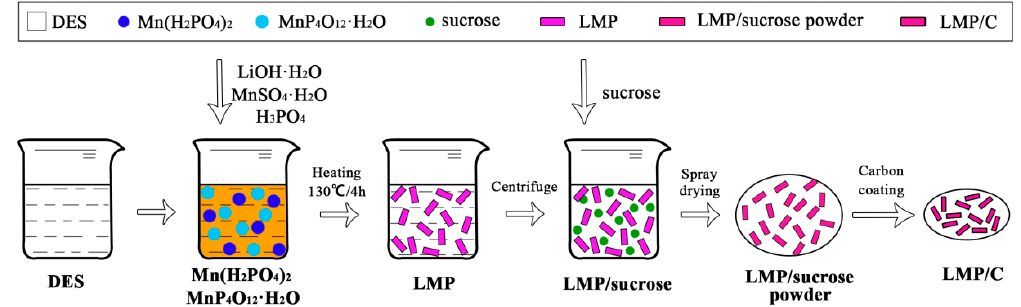
Figure 6. Schematic illustration of the formation of LiMnPO 4 /C nanorods.